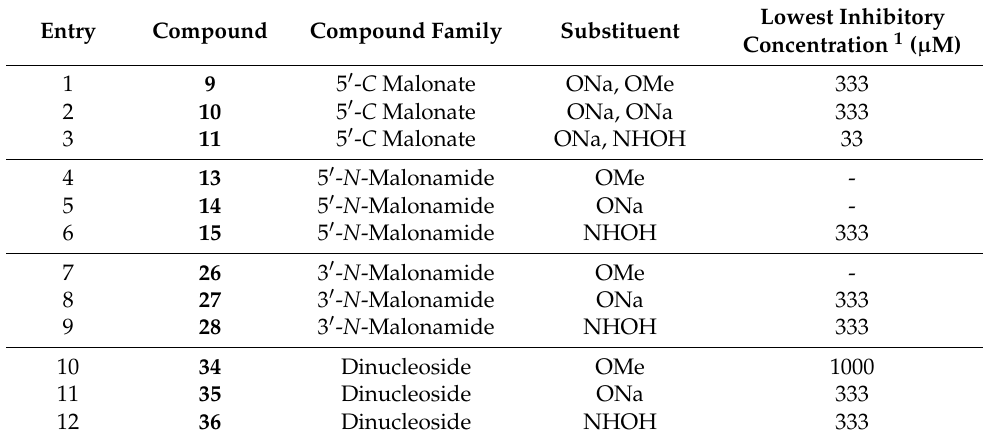
Table 1. Lowest concentrations at which inhibition was